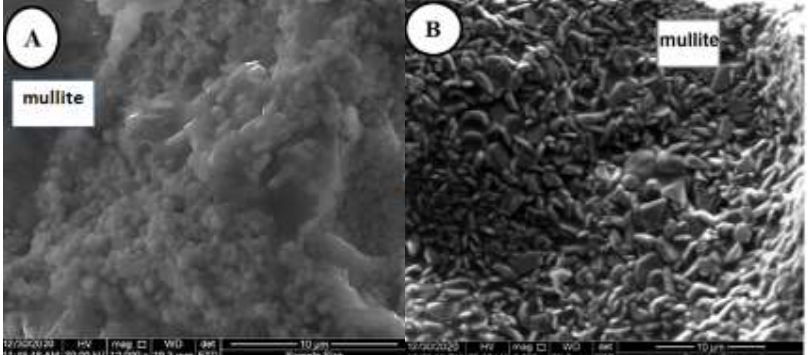
Figure 12: SEM images for prepared mortar specimen’s surfaces (A) Bentonite Mortar (B) Kaolin